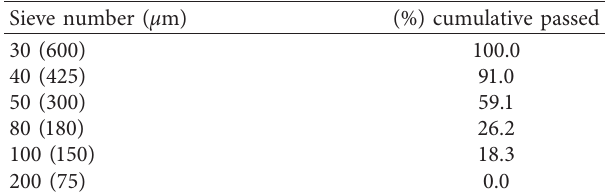
Table 2: Gradation of crumb rubber used in this